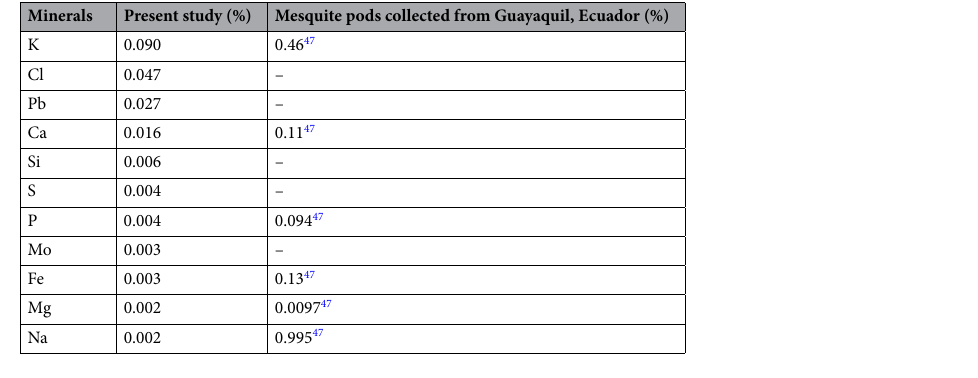
Table 3. Micro and macronutrients present in Pj